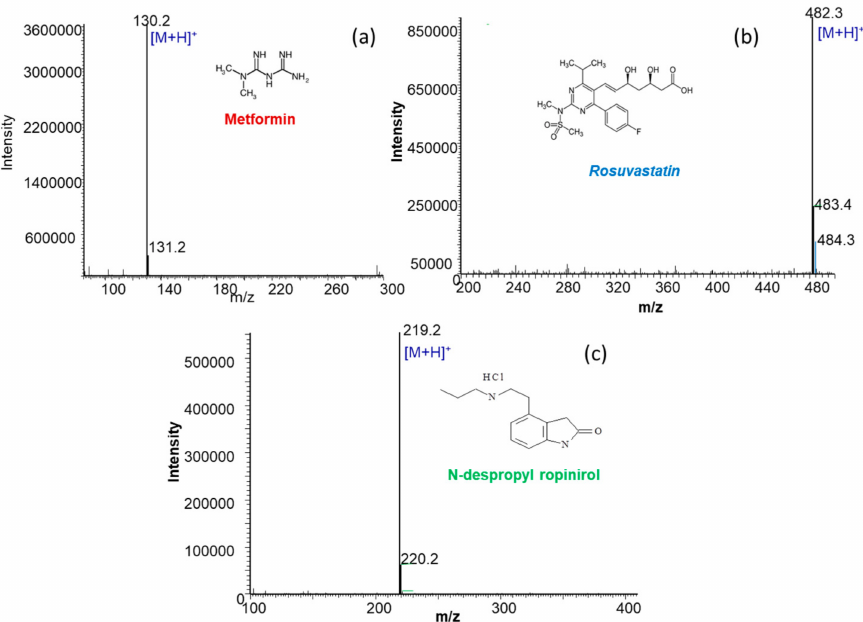
Figure 1. ESI mass spectra in positive ion mode of a 10 µ g mL − 1 solution prepared in mobile phase of ( a ) metformin ( b ) rosuvastatin and ( c ) N-despropyl